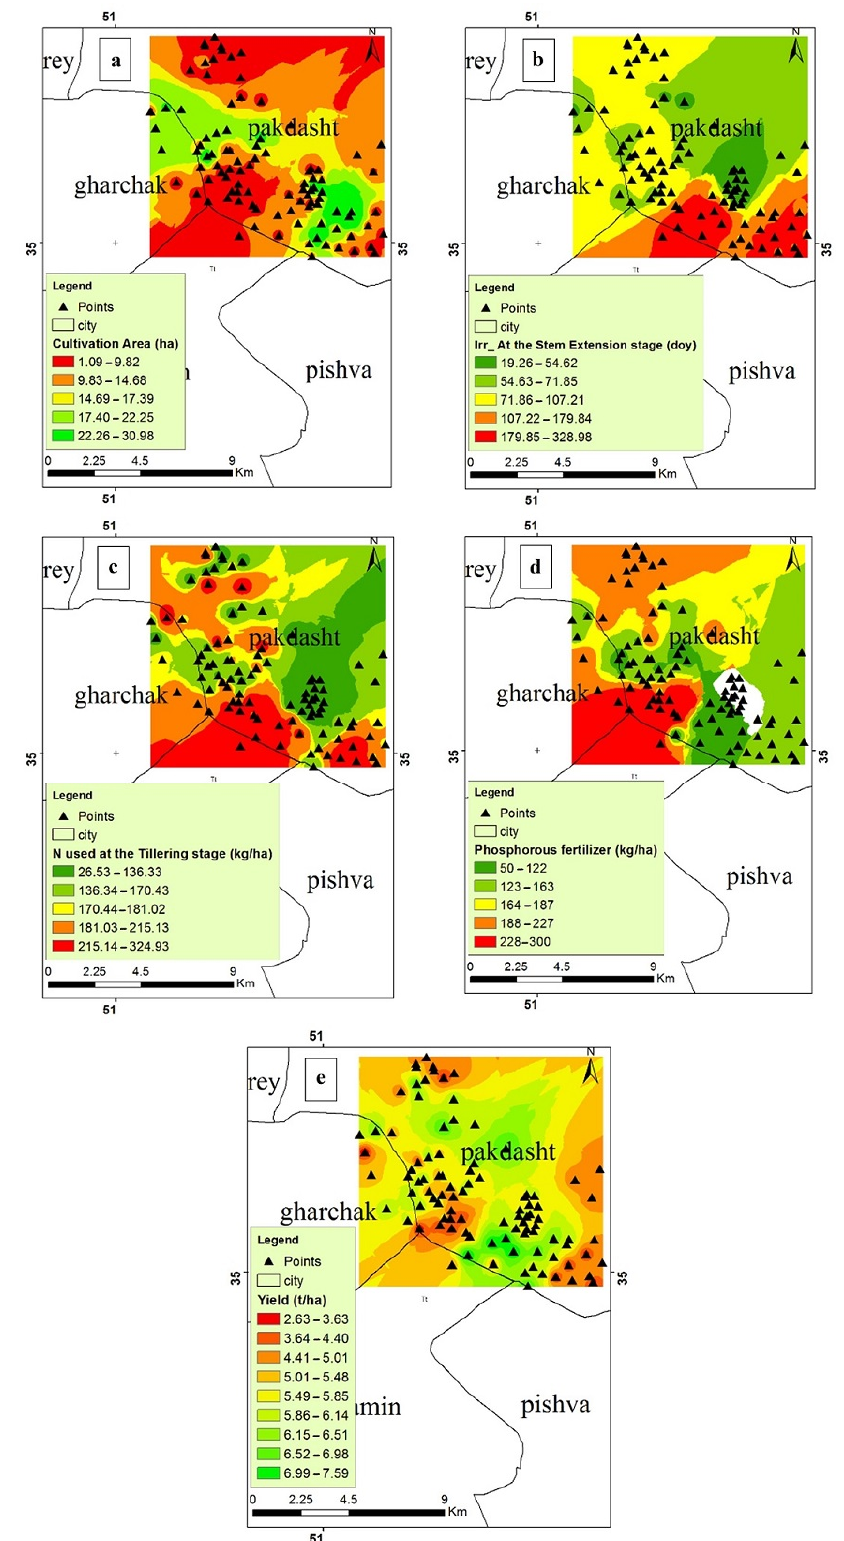
Figure 3. The range of crop management variables with a high impact on the wheat yield gap ( a – d ) and the range of wheat yield in the fields studied in Varamin Plain of Pakdasht, extracted from the results of the CPA approach. ( a ) field cultivation area; ( b ) the irrigation date at the stem extension stage; ( c ) nitrogen used at the tillering stage; ( d ) phosphorus consumption; ( e ) wheat yield.